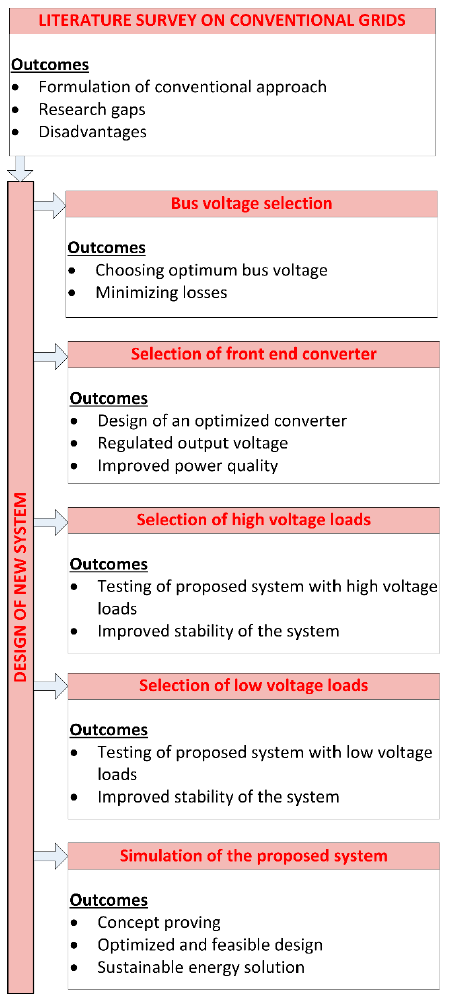
Figure 1. Methodology outline.